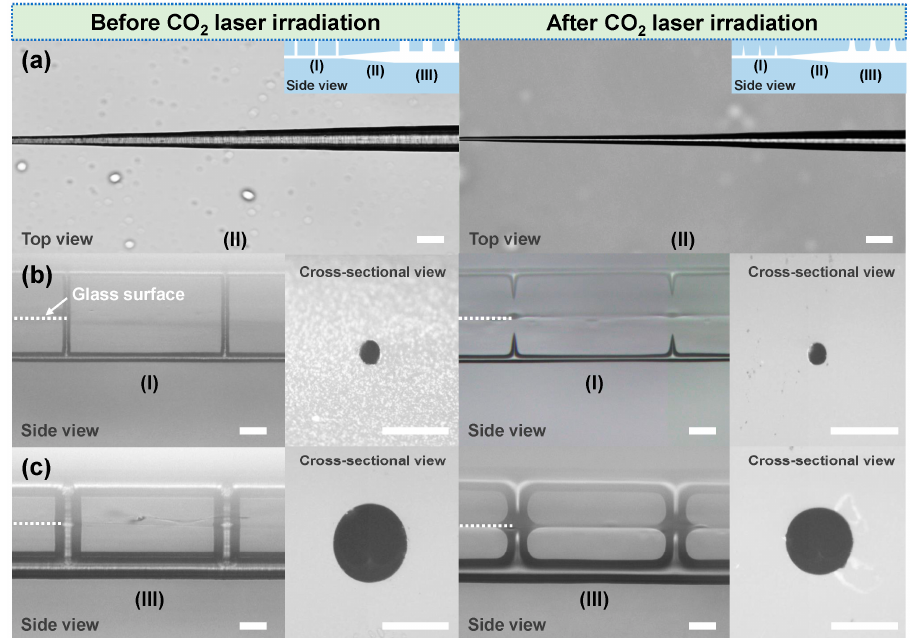
Figure 2. Optical microscopy images of different regions of 3D laser-machined glass microchannel structures before and after CO 2 laser irradiation. ( a ) Top-view optical micrographs of the tapered microchannel structure (region II). Each inset in ( a ) represents a side-view schematic of the whole microchannel structure, which consists of three regions (I, II, and III). Side-view optical micrographs of ( b ) region I and ( c ) region III of the microchannel structure. Each inset in ( b , c ) shows a cross-sectional view of the microchannel in the corresponding region. The white dashed lines in ( b , c ) indicate the glass surface. The scale bar in each figure represents 50 μ m.